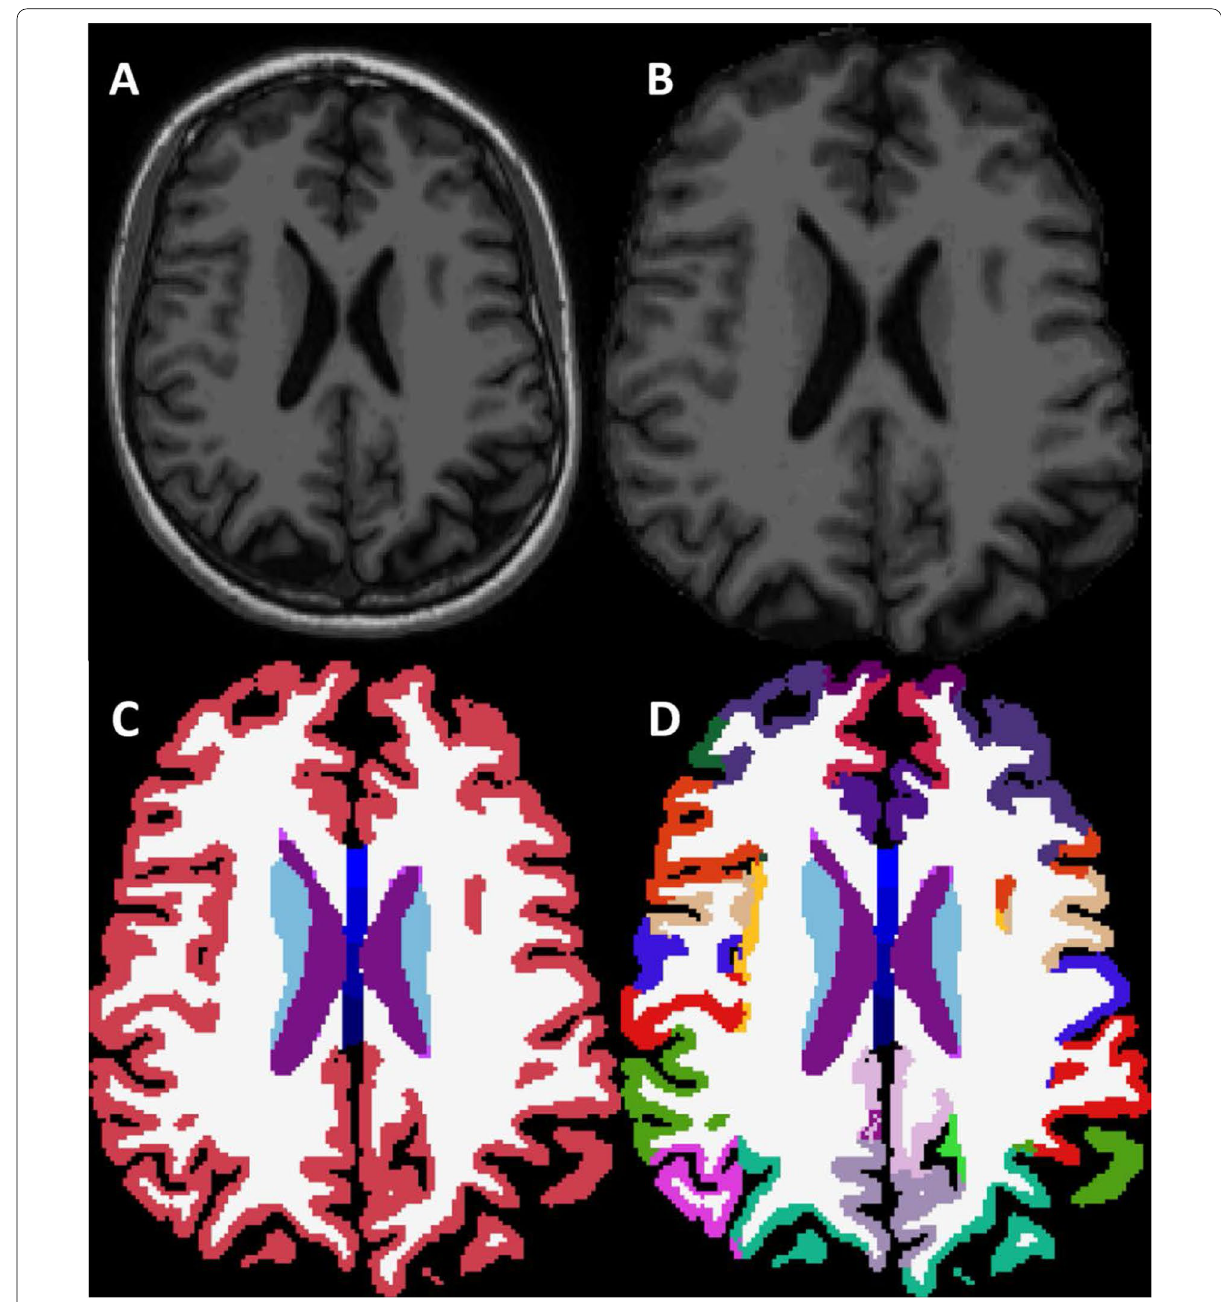
Fig. 2 A female patient aged 29 years old, known to have RRMS with EDSS score of 2.5. I. Cortex segmentation: raw T1WI axial plane ( A ), T1W image after brain extraction ( B ), gray and white matter segmentation ( C ) and cortex segmentation ( D ). II. Surface reconstruction: T1W image with pial surface (red line) and white matter surface (yellow line) ( E ) and surface reconstruction ( F ). III. Cortical thickness results in mm: The patient had significant decrease in cortical thickness of the precentral (1.9475 mm, 1.9151 mm), postcentral (1.5531 mm, 1.4447 mm), paracentral (1.8846 mm, 1.9118 mm) and posterior cingulate cortices (1.8251 mm, 2.1117 mm) in left and right side,